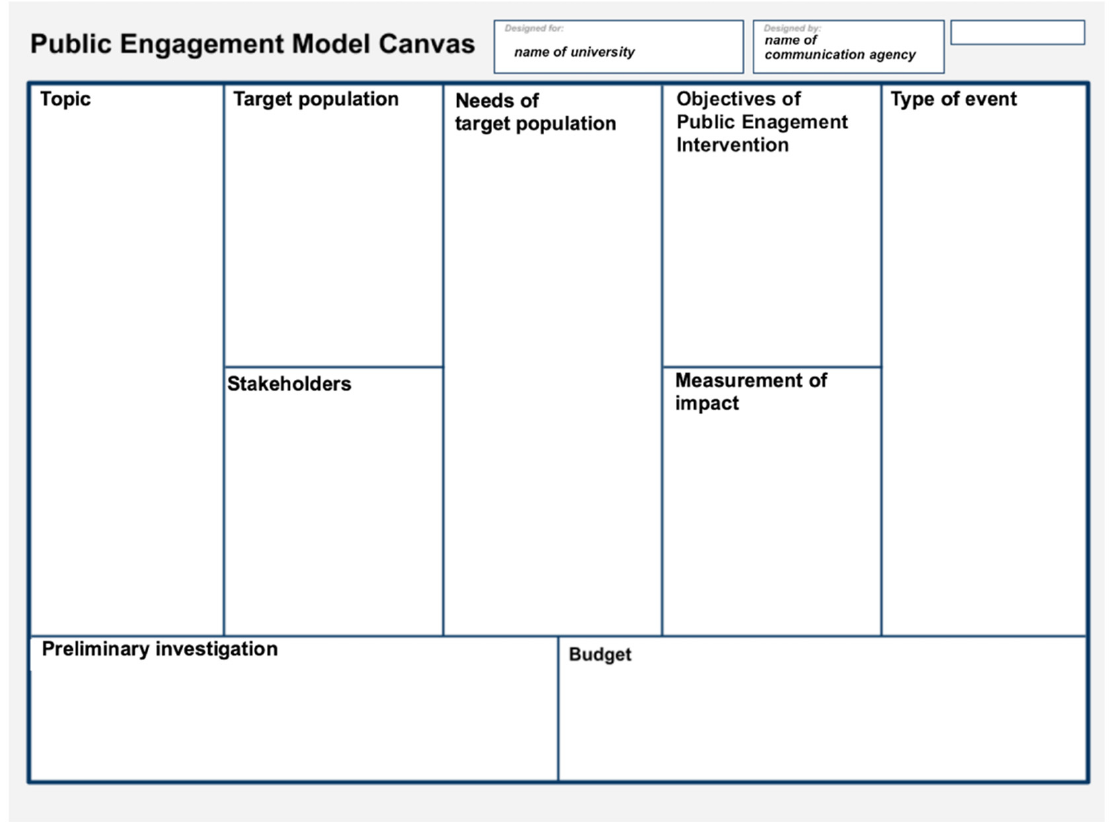
Figure 5. Public Engagement Model Canvas.